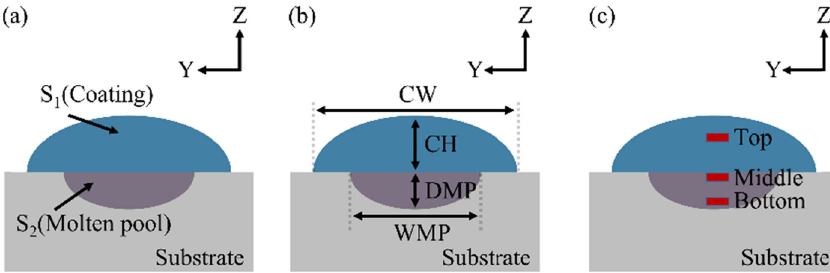
Figure 2: Schematic diagram of coating. ( a ) The coating distribution diagram. ( b ) The schematic of coating geometry. ( c ) The position distribution of SEM observation. CH: coating height, CW: coating width, DMP: depth of molten pool, WMP: width of molten pool.